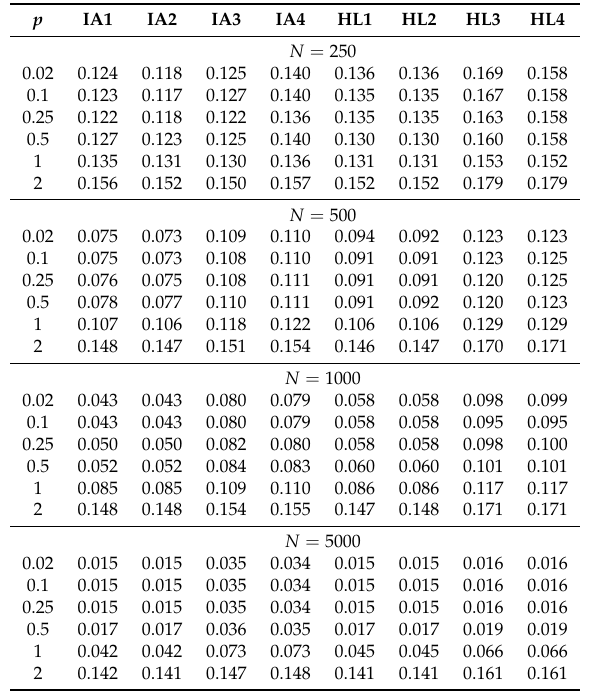
Table A3. Simulation Study 2: Average Root Mean Square Error (ARMSE) of Group Means as a Function of Sample Size in the Condition of Differential Item Functioning (DIF) and G = 3